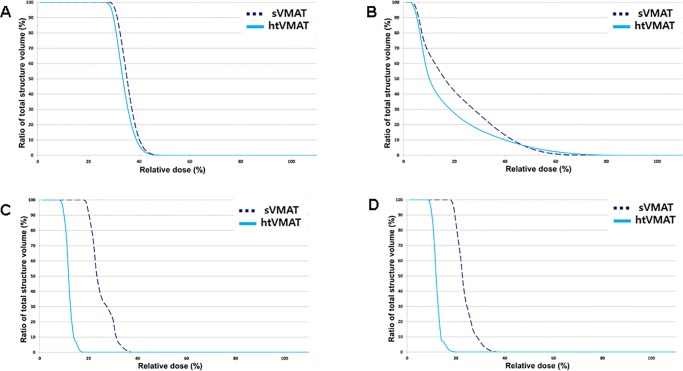
Mean dose-volume histogram comparison between volumetric-modulated arc therapy without (sVMAT) and with (htVMAT) head tilt.(A) hippocampus, (B) both parotid glands, (C) right lens and (D) left lens.